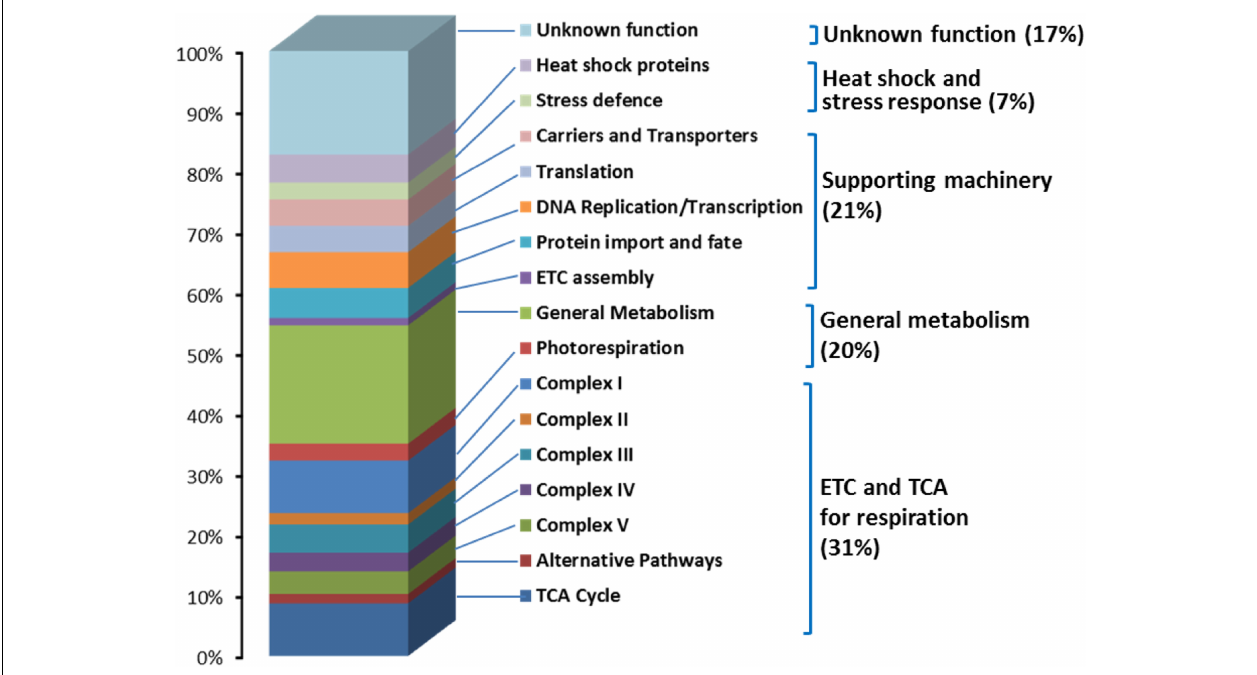
separated using gel-based and non-gel based methods and digested with trypsin before identification using mass spectrometry (Huang etal., 2009a). Rice mitochondria protein data were extracted from SupplementalTable S3 of Huang etal.